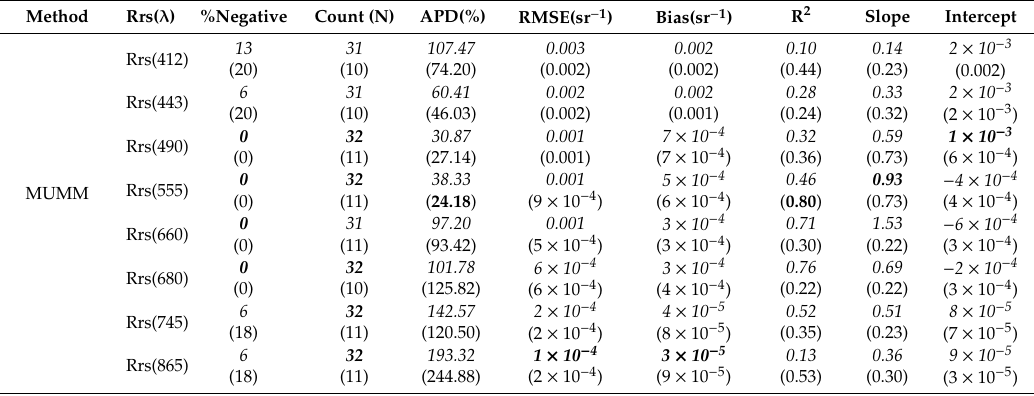
Table 4. Statistical results for GOCI-retrieved Rrs values obtained using the MUMM algorithm and the in situ Rrs comparison at 02:16, 03:16, and 04:16 UTC for ± 3 h (values in parentheses indicate results for ± 1 h). The presentation style is the same as described in Table